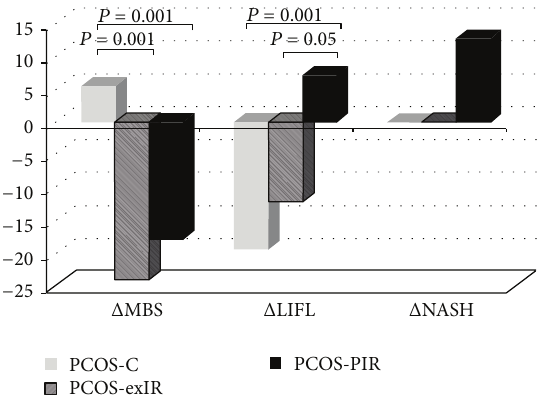
Figure 2: Comparison of metabolic/hepatic markers in the three PCOS groups (PCOS-C: patients who were insulin sensitive at baseline;PCOS-PIR:patientswithIRatbaselineandaftertreatment; PCOS-exIR: initially insulin resistant patients whose IR dissolved after treatment). Data are presented as percent changes (between baseline and after treatment) of prevalence and were analyzed using Chi 2